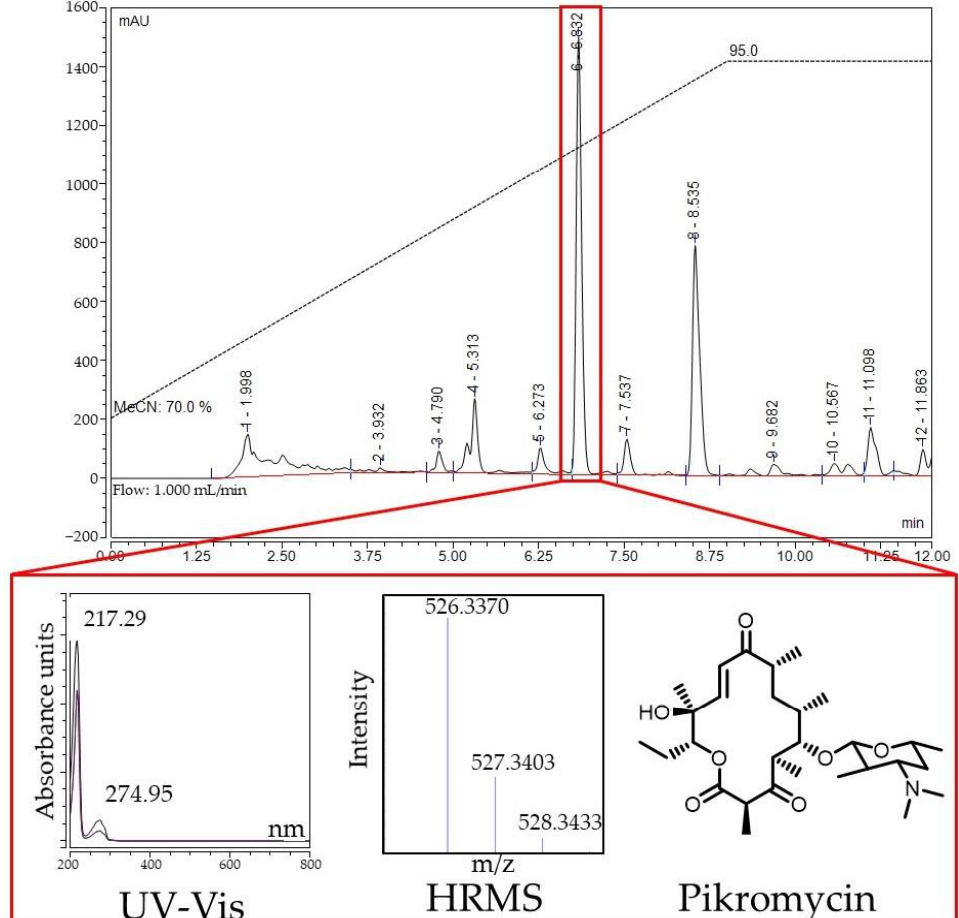
Figure 7. HPLC analysis of the active fraction of Streptomyces sp. KB-1 culture liquid. Elution with 70 → 95% MeCN in water for 9 min followed by 3 min of 95% MeCN. Red box indicates the active component on the HPLC profile.